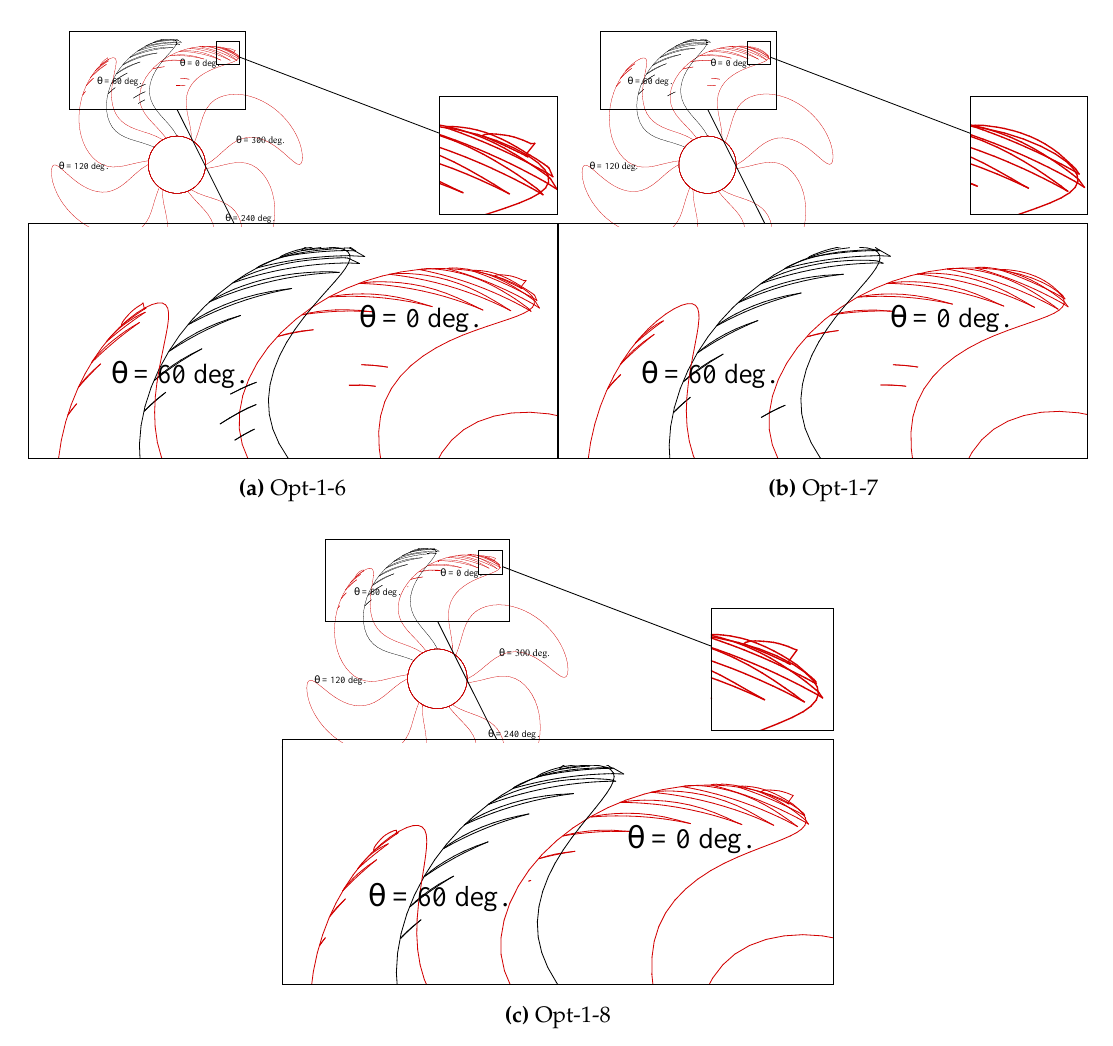
Figure 5. Cavitation performance of propeller case Opt-1, Group 2. ( a ) Opt-1-6; ( b ) Opt-1-7; ( c )